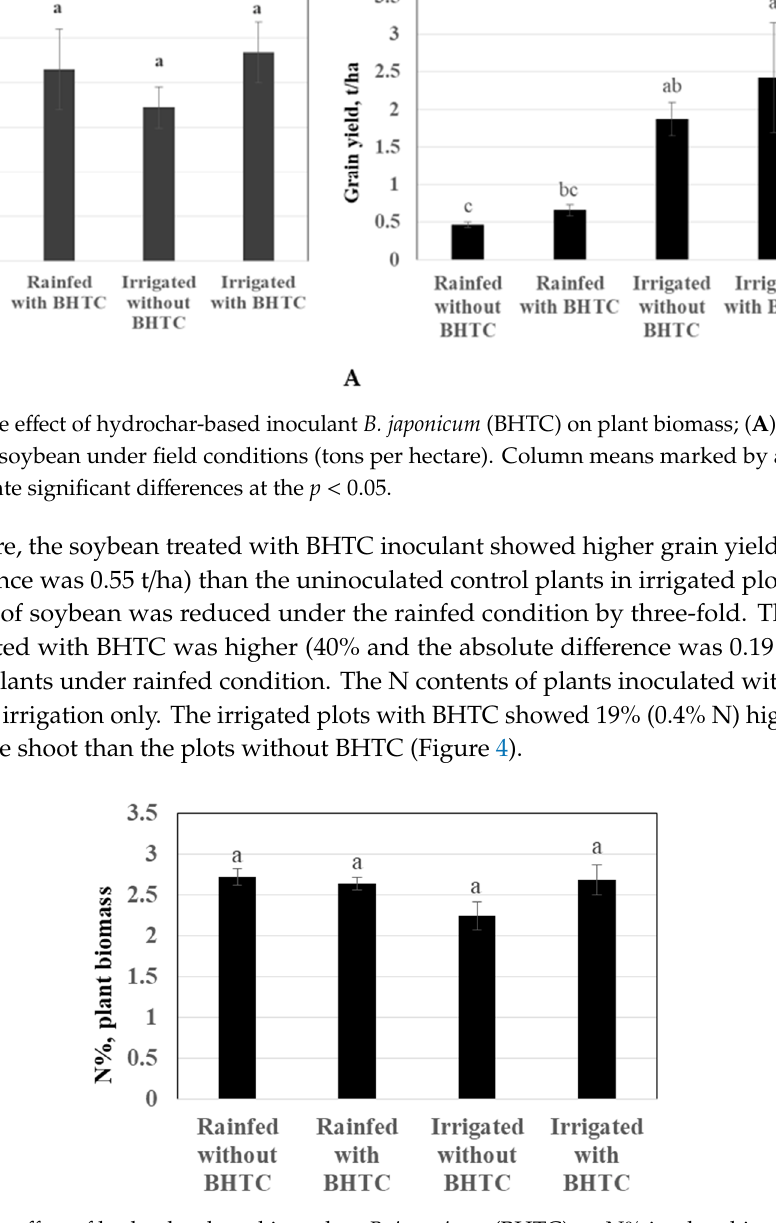
Figure 4. The effect of hydrochar-based inoculant B. japonicum (BHTC) on N% in plant biomass under field conditions. Column means marked by letters indicate significant differences at the p < 0.05.